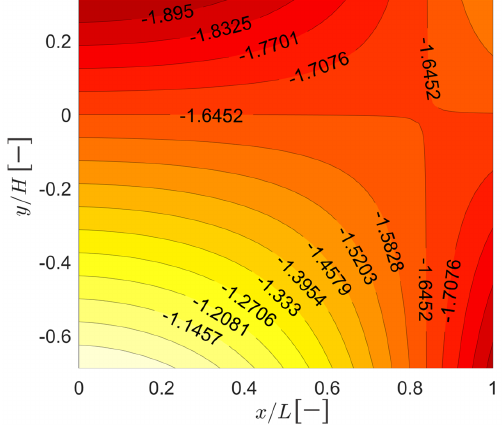
Figure 14. Normalized apparent static